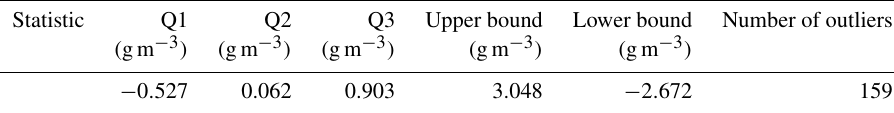
Table 2. Characteristic values of the box plots in Fig. 10b.